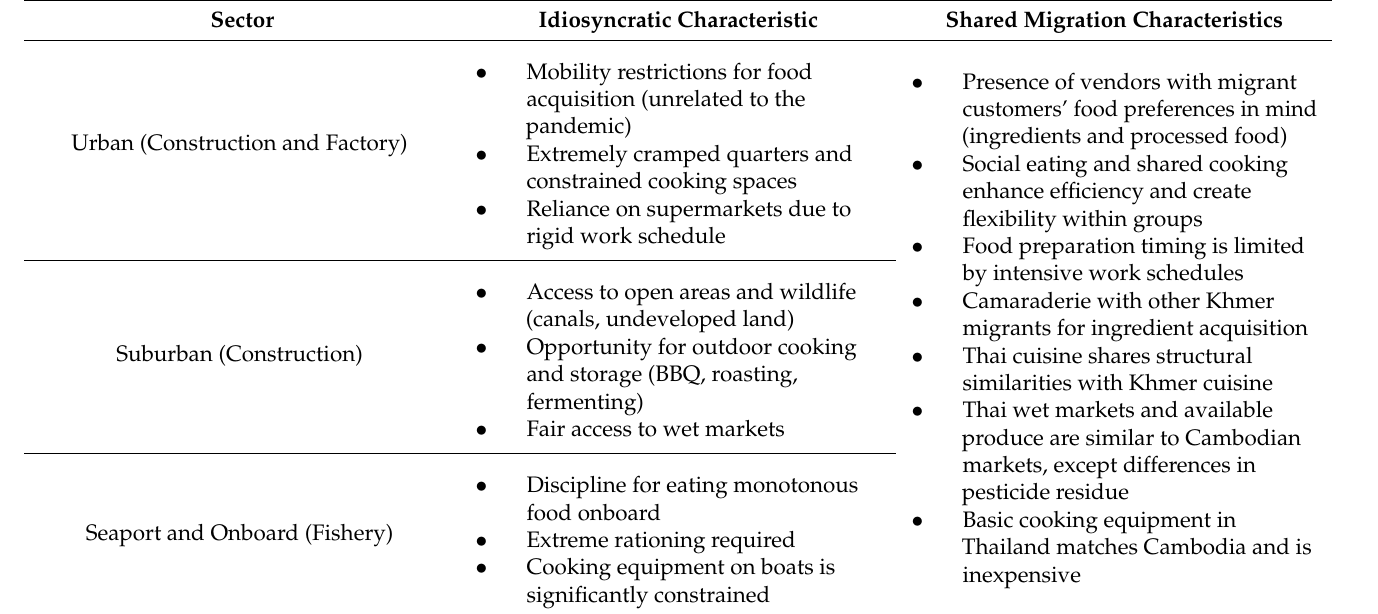
Table 1. Sectoral and spatial differences in migrant destination food